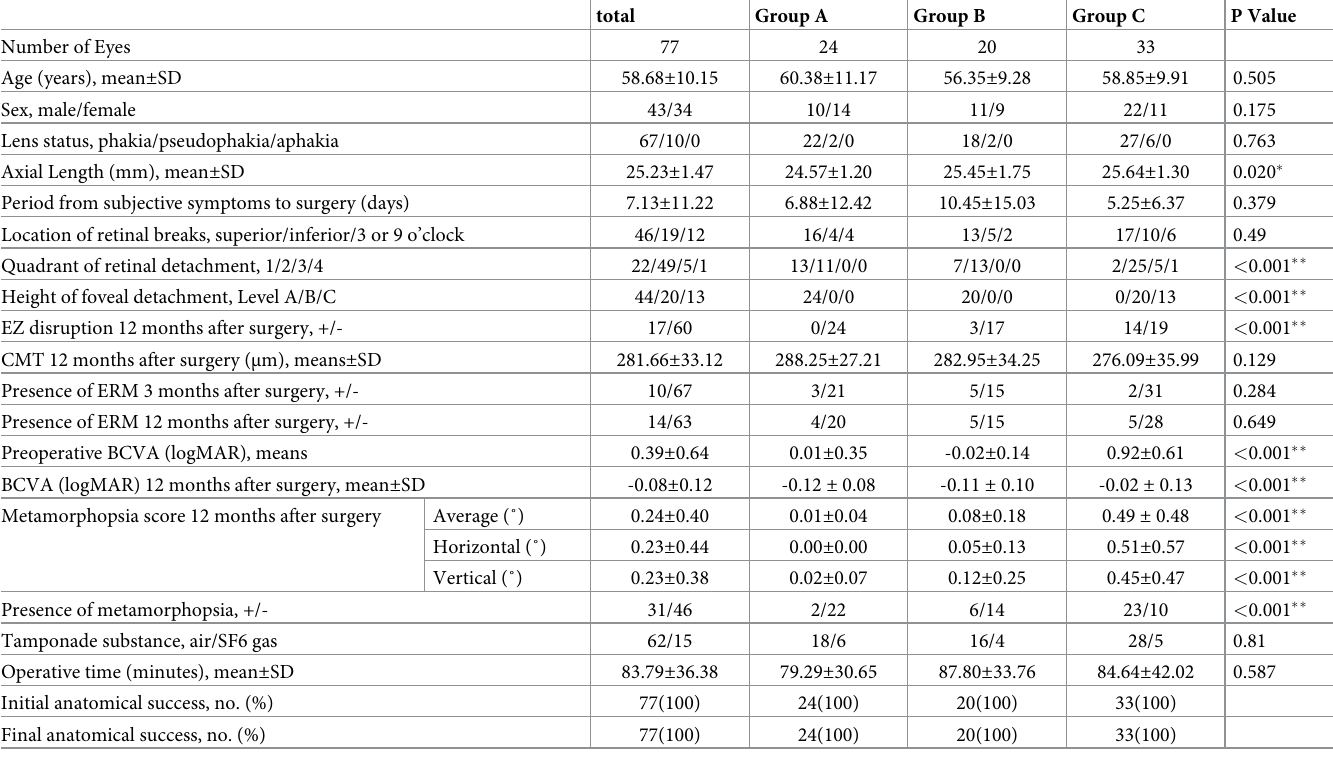
Table 4. Comparison of the demographic data of patients among